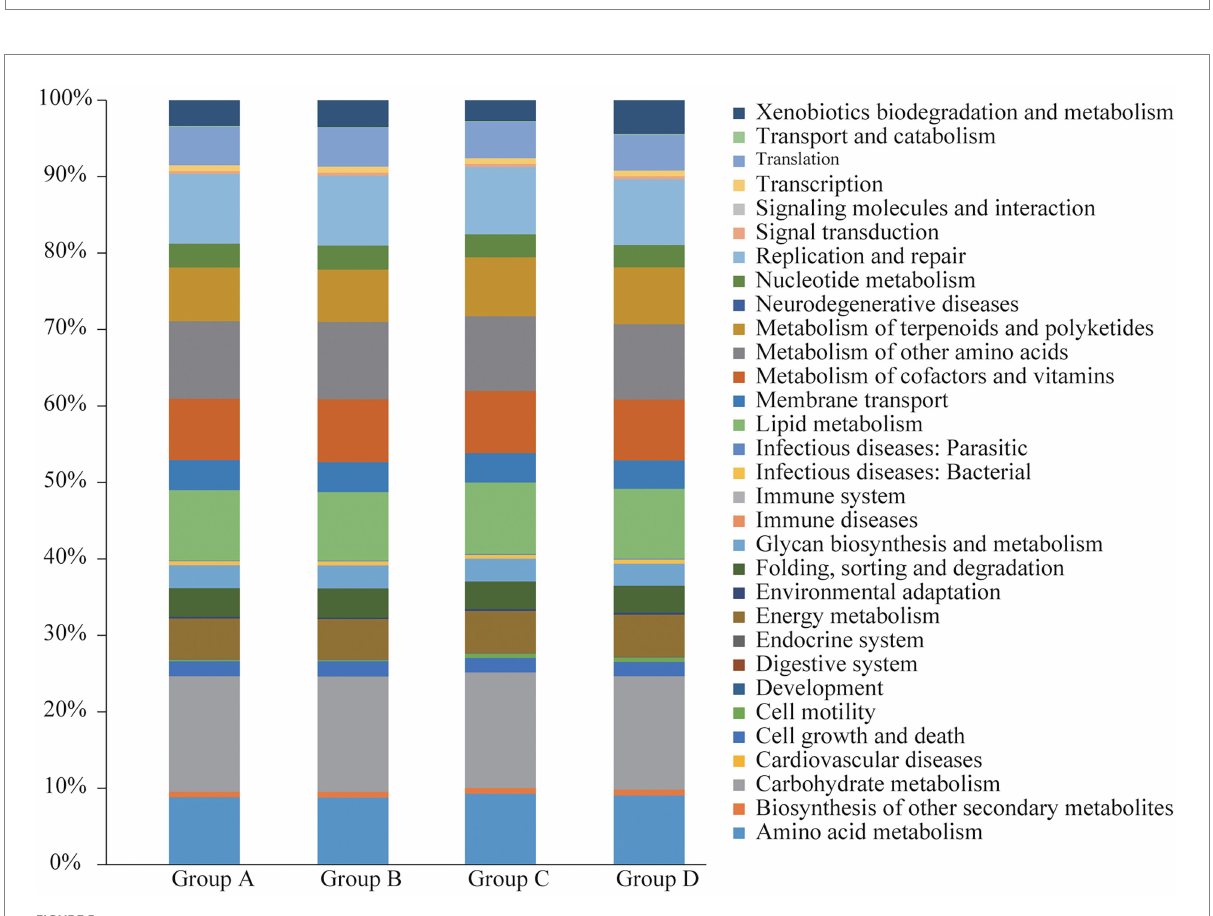
FIGURE 5 Functional analyses of bacterial composition from Groups A, B, C, and D,